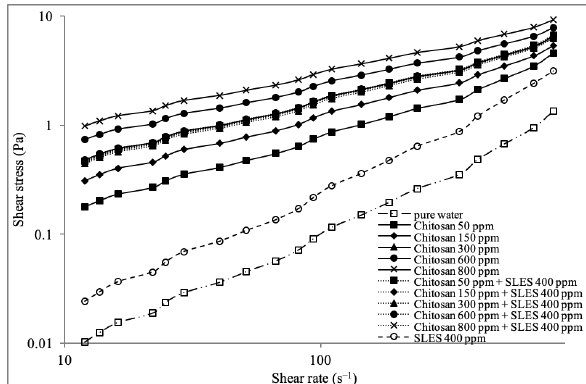
Figure 2: Shear stress of chitosan, SLES, and chitosan–SLES com- plex solutions compared to pure water as a function of shear